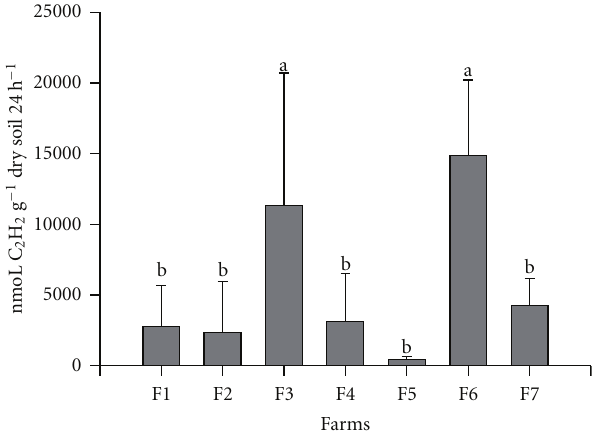
Figure 2: Nitrogen fixing bacteria count in NFB agar. Values having the same letter were not significantly di ff erent according to Kruskal Wallis pairwise test, P = 0 . 05 significance level. The error bars shown correspond to the standard deviation of the microbial count for each farm.